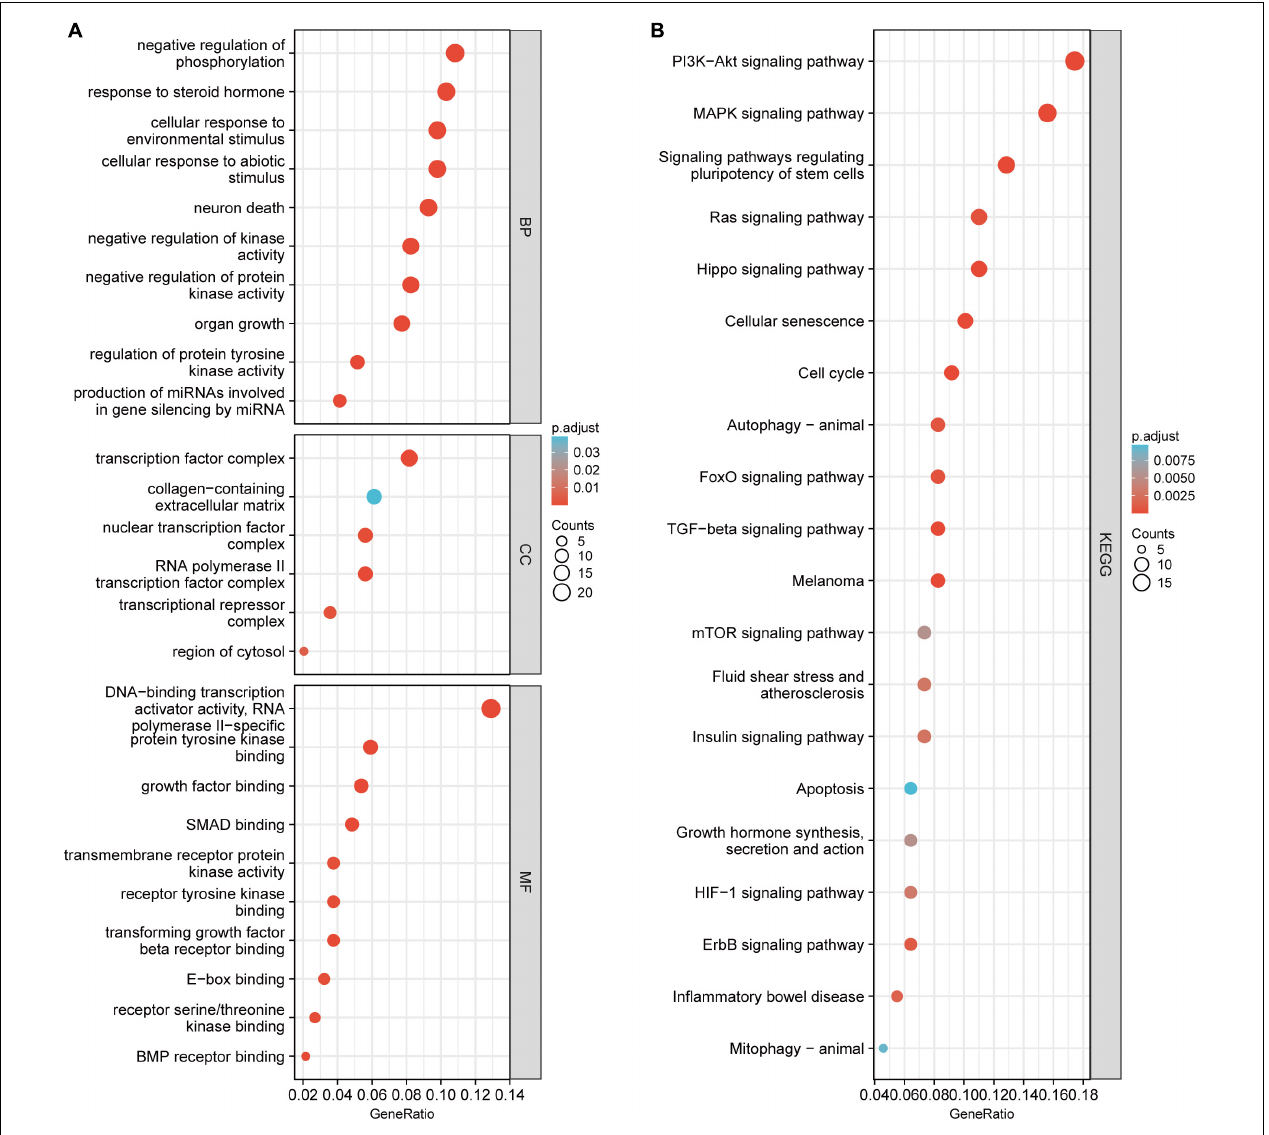
FIGURE 4 | The GO and KEGG pathway enrichment analysis for 200 mRNAs. (A) The major enriched and meaningful GO terms. (B) The top 20 enrichment scores in the KEGG pathway analysis. GO, Gene Ontology; BP, biological processes; CC, cellular components; MF, molecular functions; KEGG, Kyoto Encyclopedia of Genes and